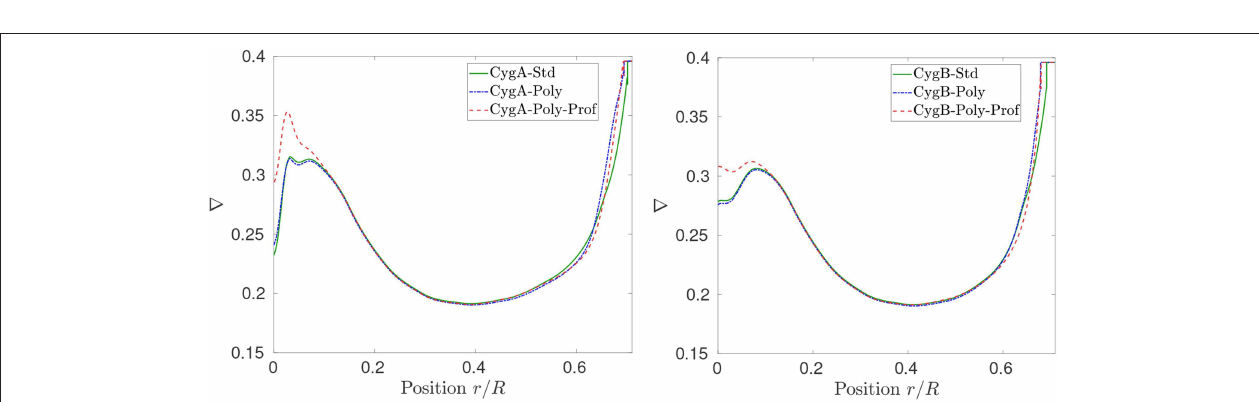
FIGURE 10 | Comparison between the observed frequency ratios and those of the 16Cyg A and B models considered in this study.